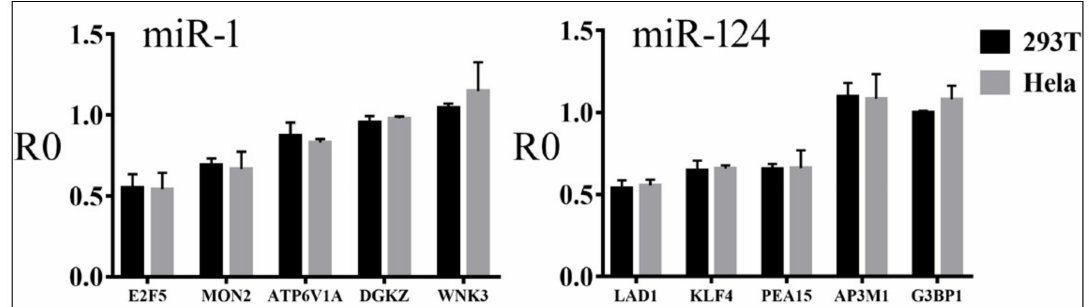
Figure 4. Reporter assay results in 293T cells and HeLa cells. Y -axes are the R0 values, and x -axes are the potential miR-1 and miR-124 targets. Averages and standard deviations are